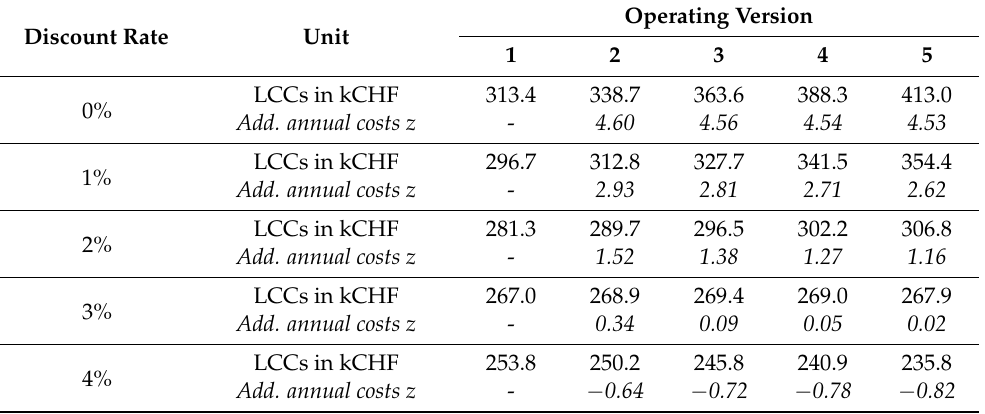
Table 2. Life-cycle costs for five operating versions assuming different discount rates (present value).